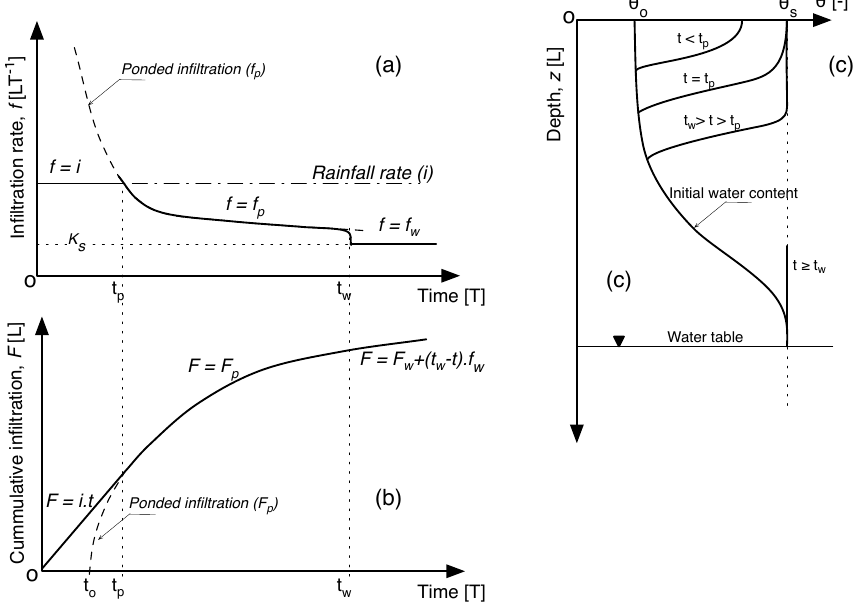
Figure 2. Conceptual curves of (a) infiltration rate, f ; (b) cumulative infiltration, F ; and (c) soil water redistribution, θ , under shallow water table, for soil without initial ponding, and constant rainfall rate ( i ) conditions. The singular times for ponding ( t p ) , shifting ( t 0 ) and to reach column saturation ( t w ) , and final infiltration rate ( f w ) after the wetting front reaches the water table ( t ≥ t w ) are